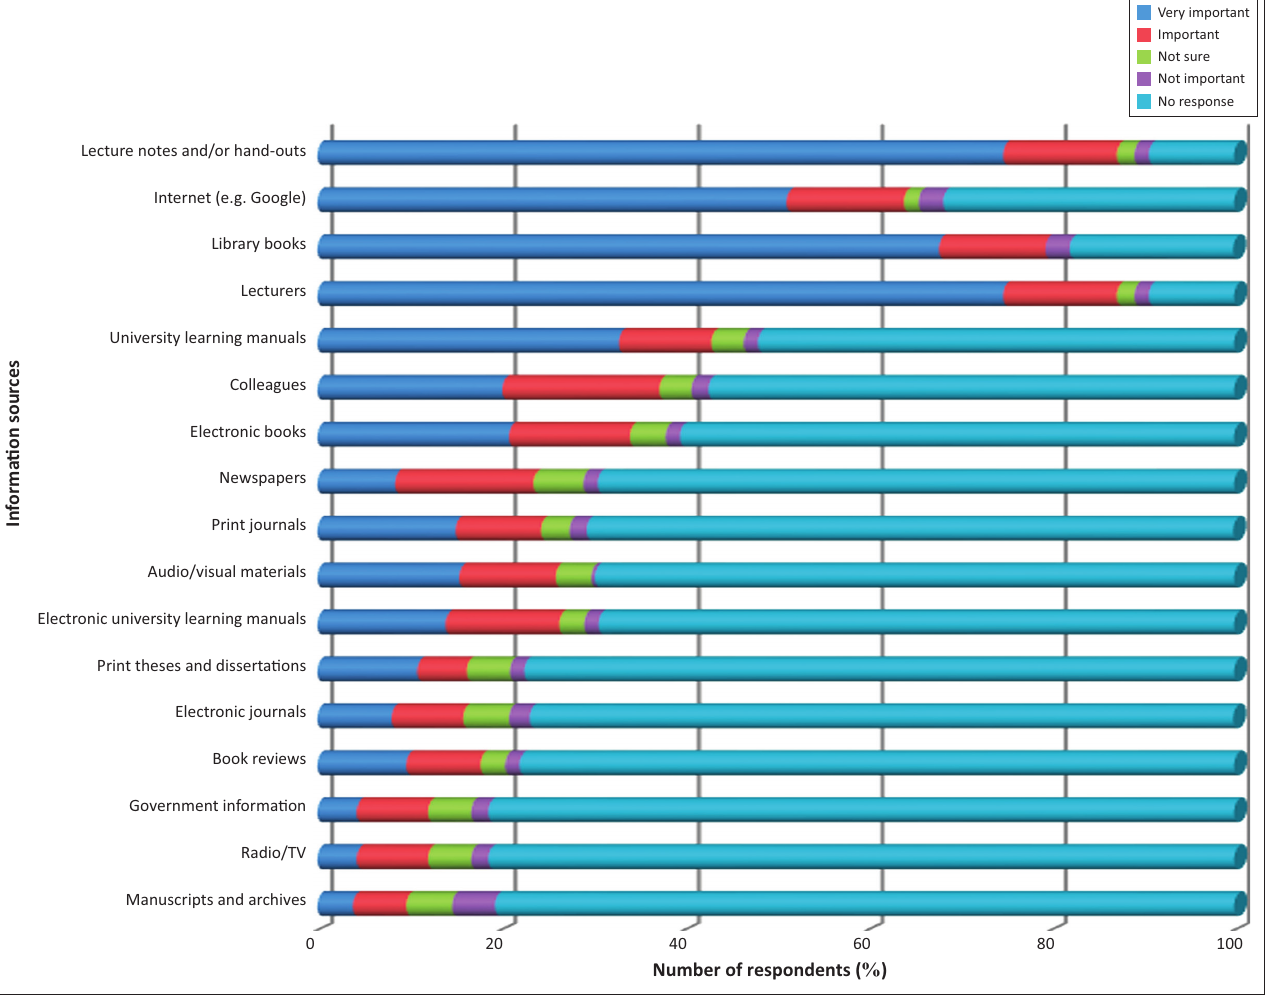
FIGURE 4: Importance of the information sources ( n =